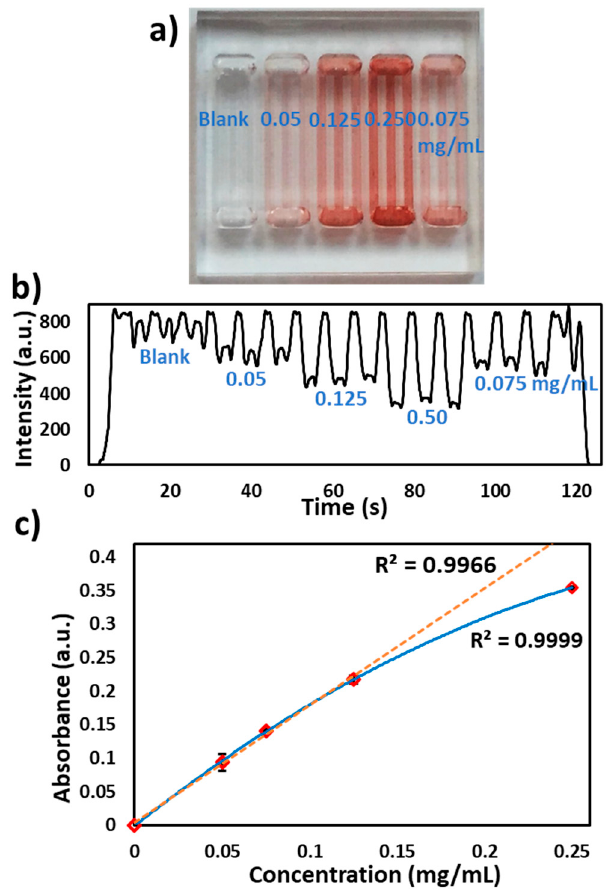
Figure 5. Nitrocefin coated microchip reaction with β‐ lactamase in microchannels. ( a ) Photograph of the microchip with the loading of different concentrations of nitrocefin (blank, 0.050, 0.075, 0.125 and 0.250 mg/mL), ( b ) Transmitted light intensity profile of reaction of different concentrations of nitrocefin with β‐ lactamase. ( c ) Graph of the nitrocefin concentration vs absorbance measured via the flow cell.